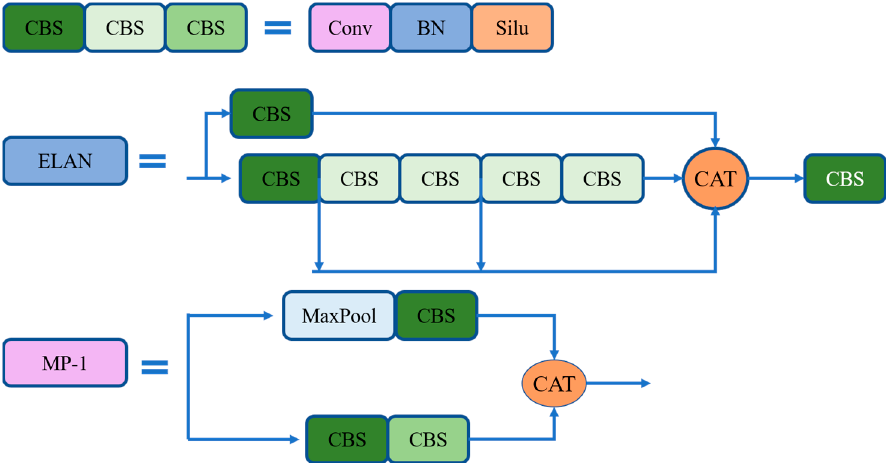
Figure 5. The CBS structure, ELAN structure, and MP-1 structure of backbone.